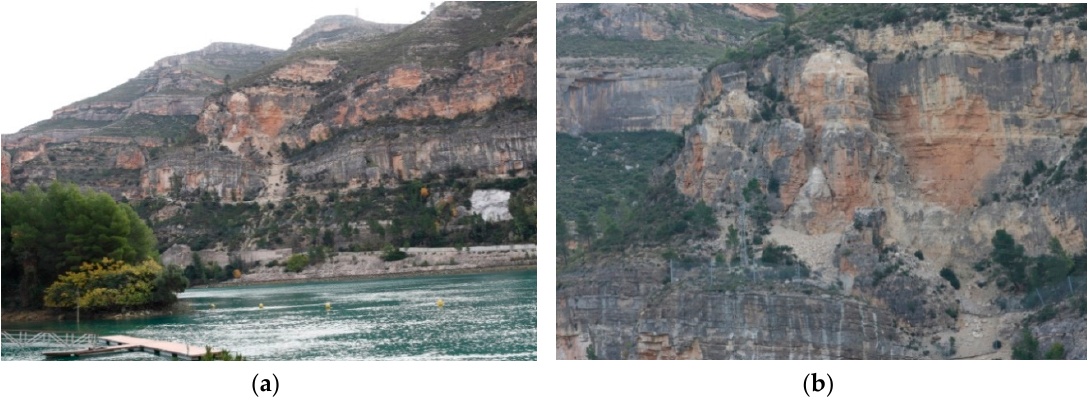
Figure 4. Images acquired from the same spatial position with two fixed lenses: ( a ) normal 50 mm; ( b ) telephoto 200 mm.